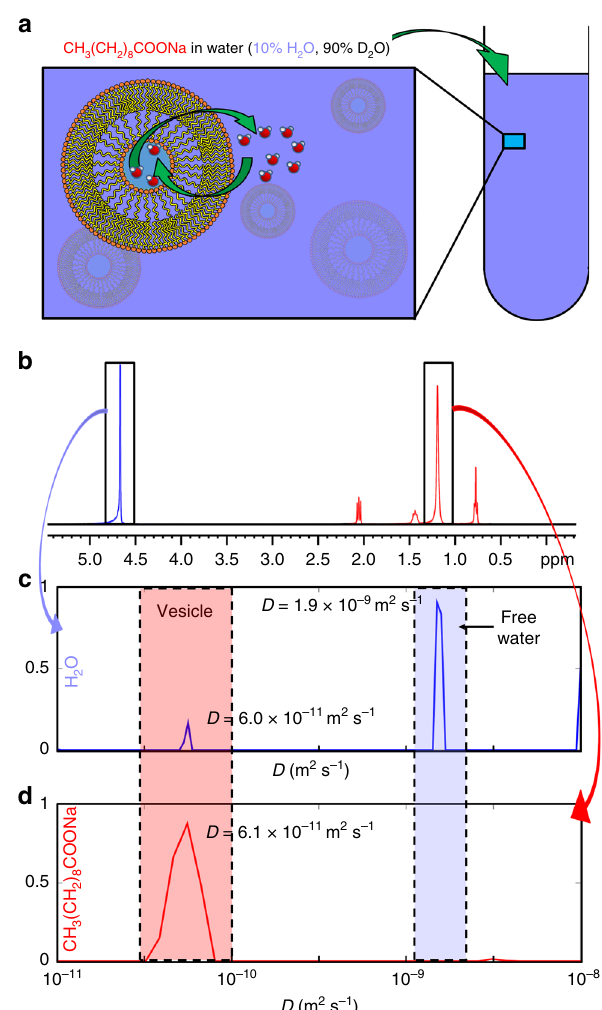
Fig. 2 Aqueous sodium decanoate (717 mM) sample. a UF DEXSY analysis implies that decanoate molecules, illustrated by an orange hydrophilic head and a yellow hydrophobic tail, form vesicles and that there is a diffusion driven exchange between the water molecules (oxygens and hydrogens illustrated by red and white) encapsulated within vesicles and free water molecules. Green arrows represent the exchange process. b 1 H spectrum of the sample. Blue and red colors highlight the water and decanoid signals, respectively. c Diffusion coef fi cient distribution of water measured by diffusion-ordered spectroscopy (DOSY). d DOSY diffusion coef fi cient distribution of decanoate. Blue and red arrows indicate, from which signals in the spectrum the diffusion coef fi cient distributions were extracted. Shaded red and blue areas indicate the diffusion coef fi cient regions of vesicles and free water,